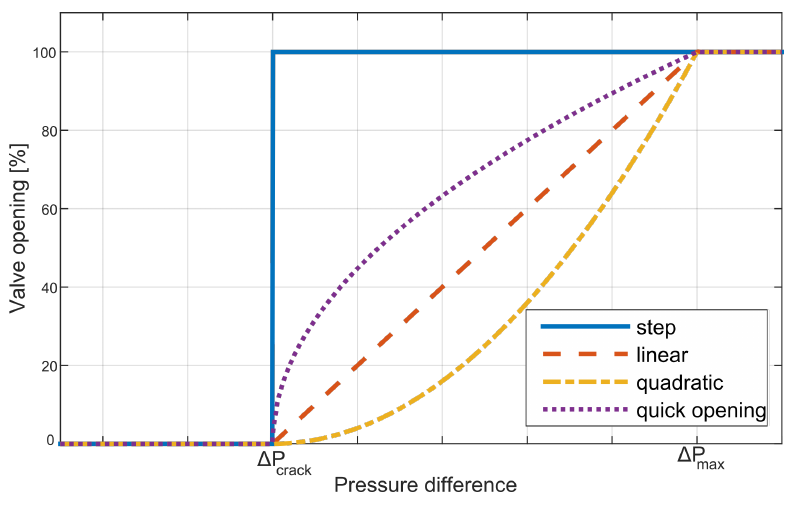
Figure 5. Valve opening